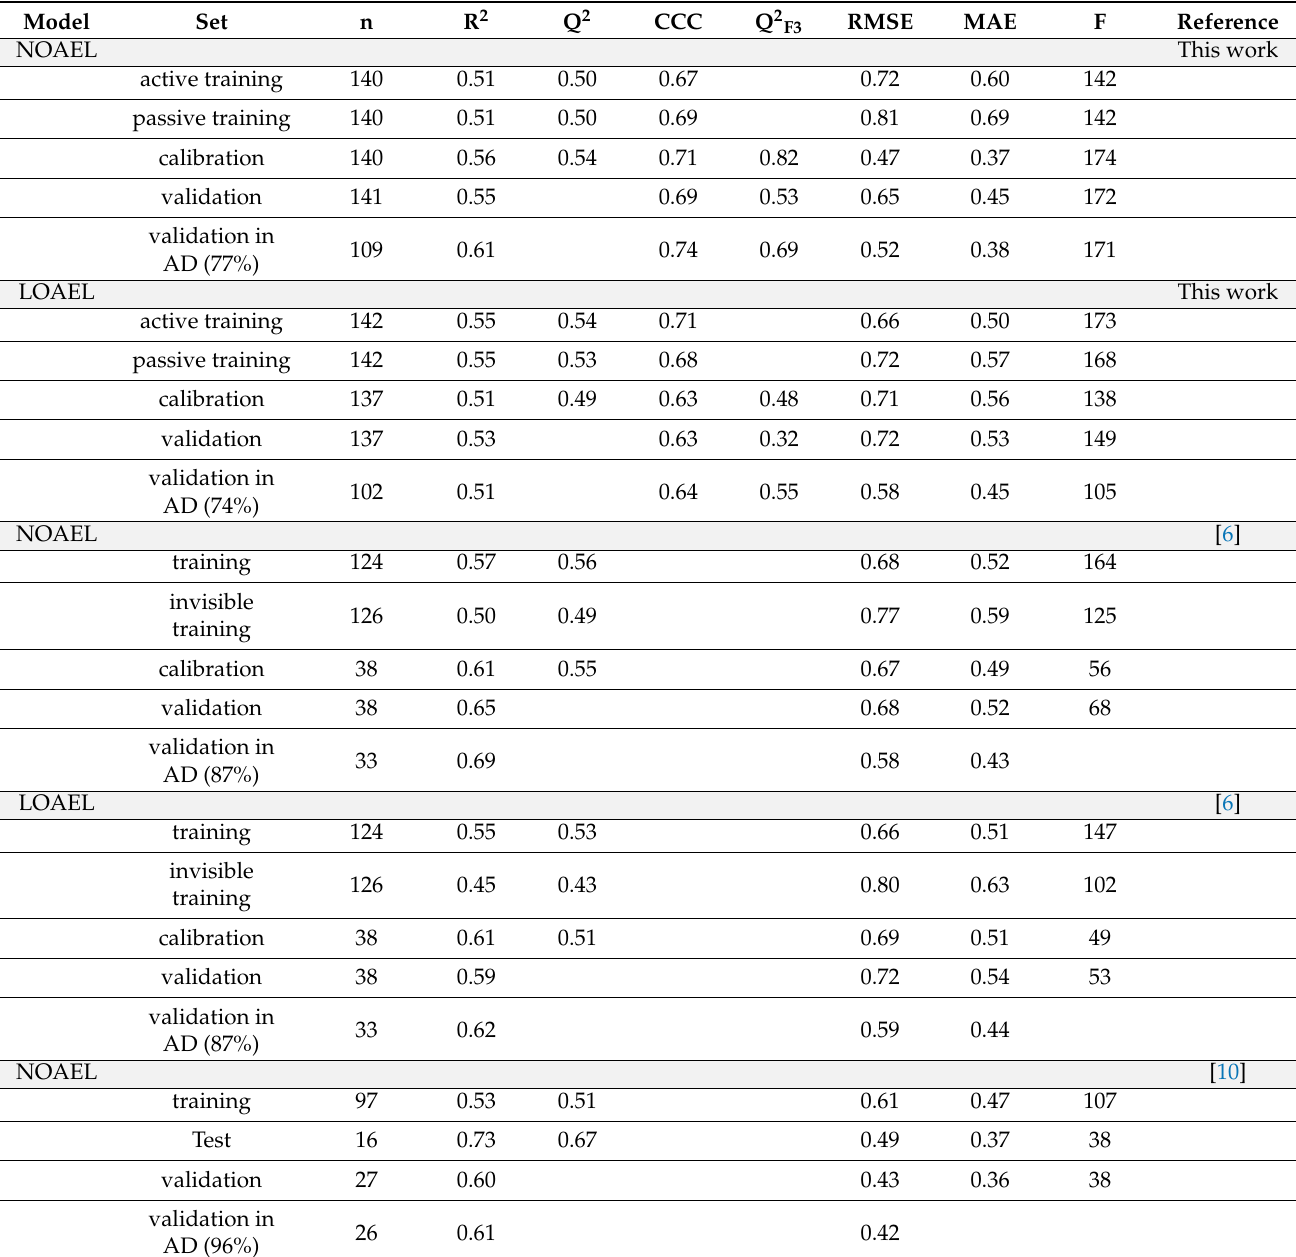
Table 2. Comparison of QSAR models for NOAEL and LOAEL in rats for sub-chronic repeated-dose toxicity (90 days exposure) in the